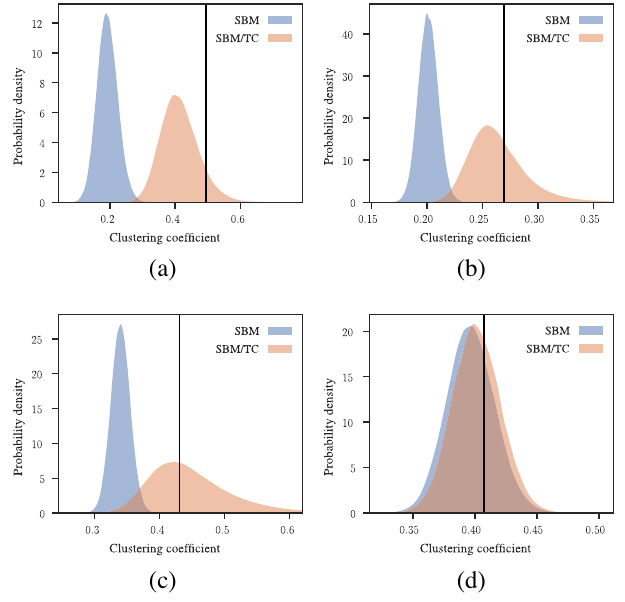
FIG. 8. Posterior predictive distributions of the clustering coefficient, as described in the text, for the SBM and SBM/ TC as indicated in the legend, for different data sets. The vertical line shows the empirical value C ð G Þ . (a) Cooperation between students (b) Adolescent health (comm26) (c) Scientific collab- orations in Network Science (d) NCAA college football